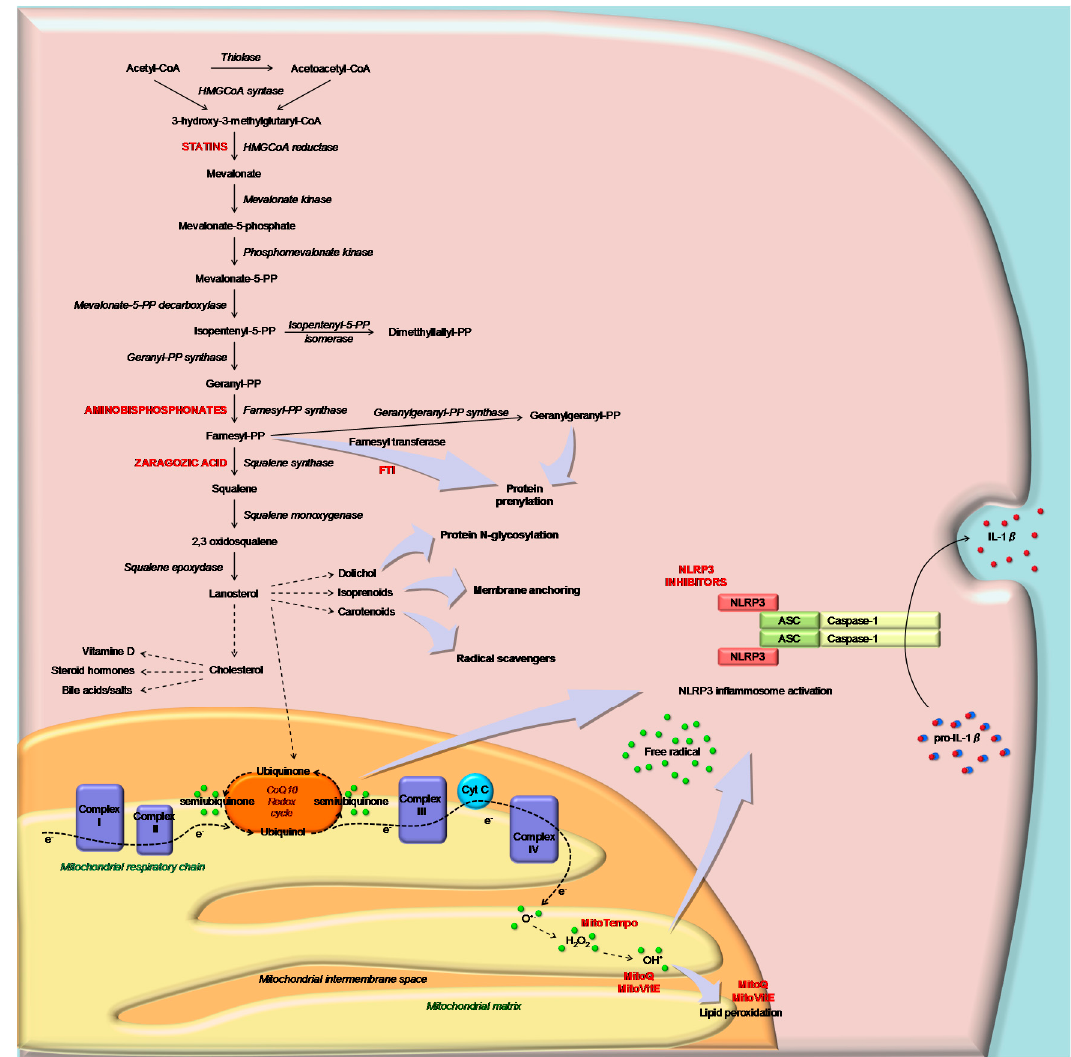
Figure 2. Schematic representation of the cholesterol pathway and of the mediation of sterol metabolites (ubiquinone) in mitochondrial respiratory function (Complex I–IV) in response to the inflammation signal. Inhibitors of CP and MTAse (as MitoQ) are indicated in capital and red characters: statins, aminobisphosphonate, squalene synthase and farnesyltransferase inhibitors. The block of CP leads to the activation of the NLRP3 inflammasome and consequently IL-1 β through mitochondrial signals.